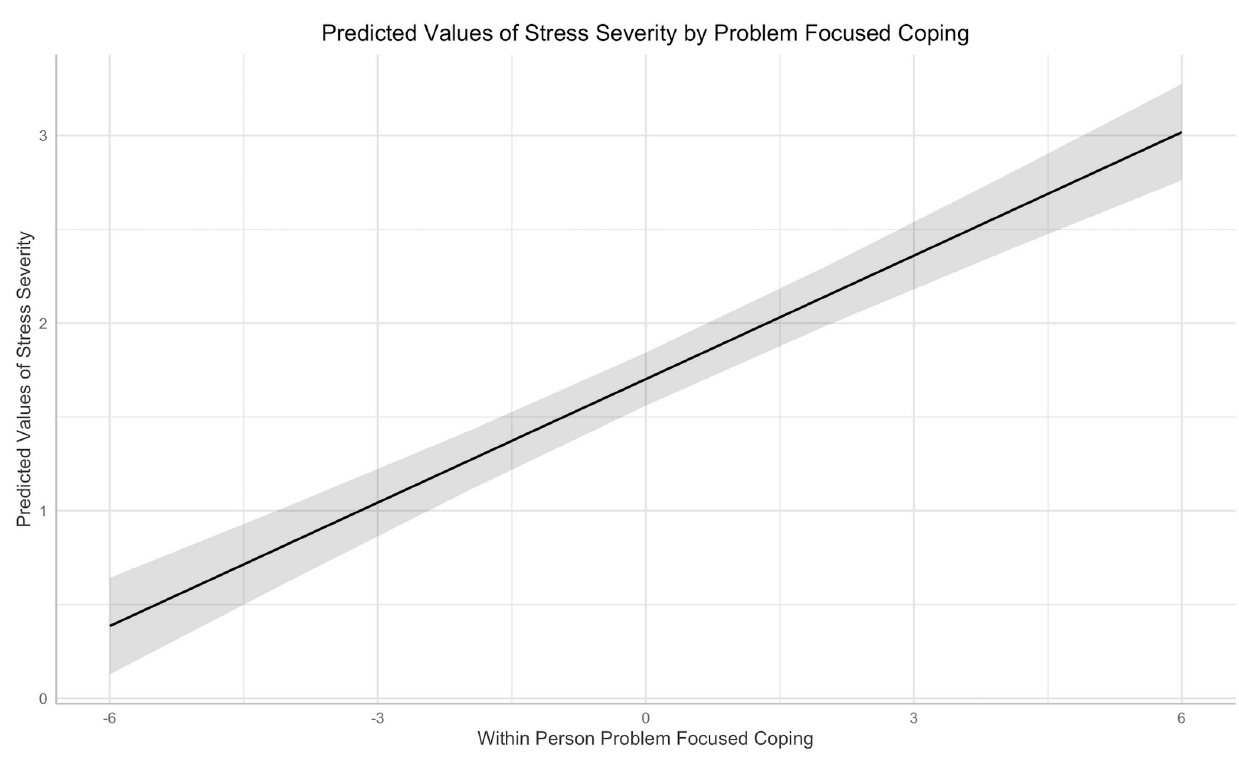
Fig 3. Predicting stress severity from fluctuations in problem-focused coping. The centered within-person coping variable ranged from -5 to 6, reflecting an individuals’ deviation from their typical use of problem-focused coping strategies.